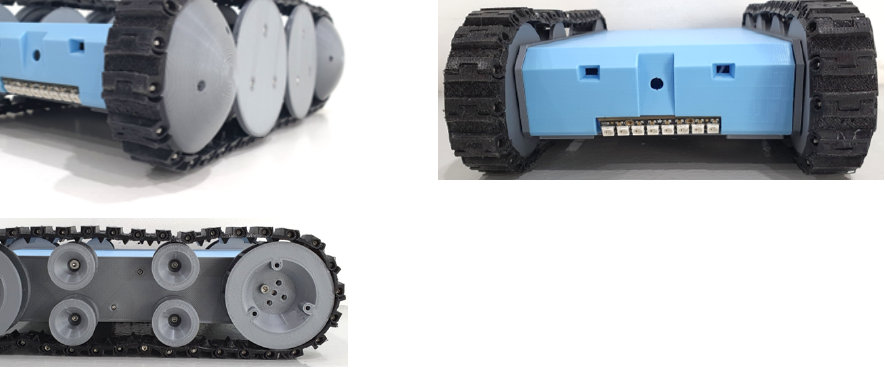
Figure 4. Falcon in multiple perspectives. Table 1. Technical specifications of